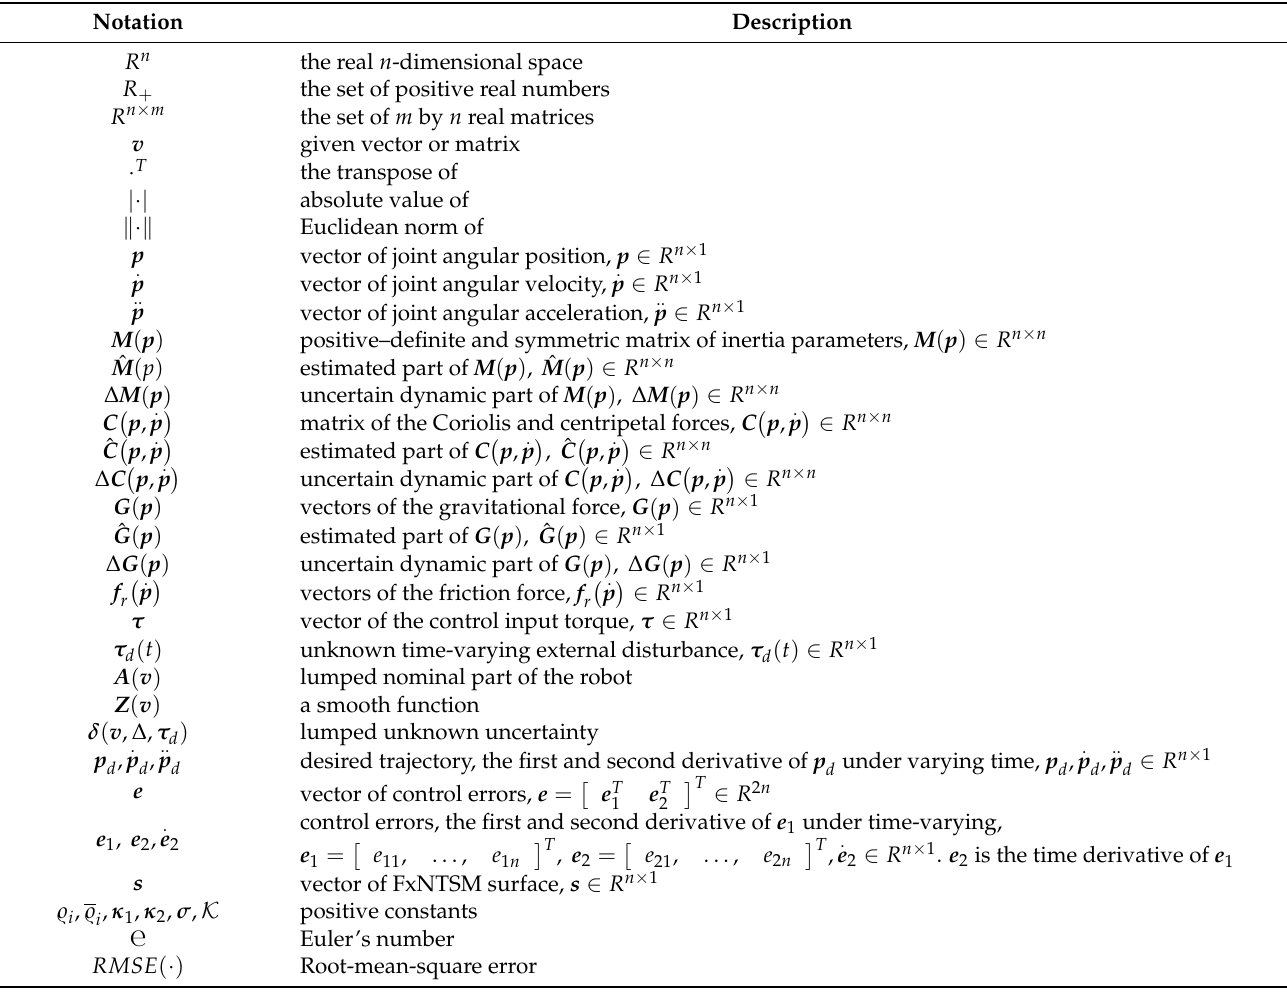
Table 1. Notations and